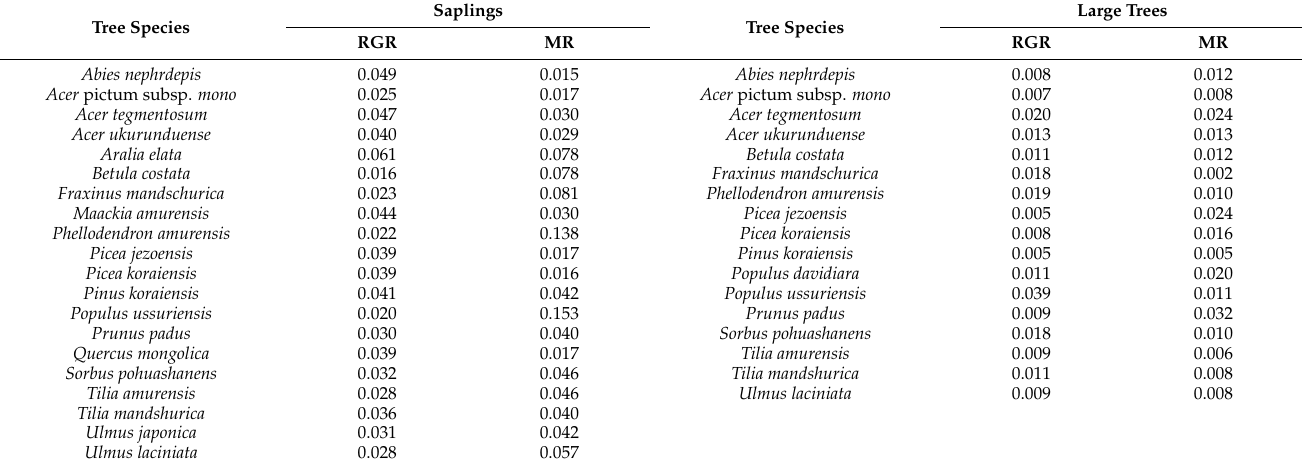
Table 1. RGR (cm cm − 1 year − 1 ) and MR (year − 1 ) for saplings (1 cm ≤ DBH < 10 cm) and large trees (DBH ≥ 10 cm) in the 9 ha dynamic plot of typical mixed broadleaved Korean pine forest. Saplings Large Trees Tree Species Tree Species RGR MR RGR MR Abies nephrdepis 0.049 0.015 Abies nephrdepis